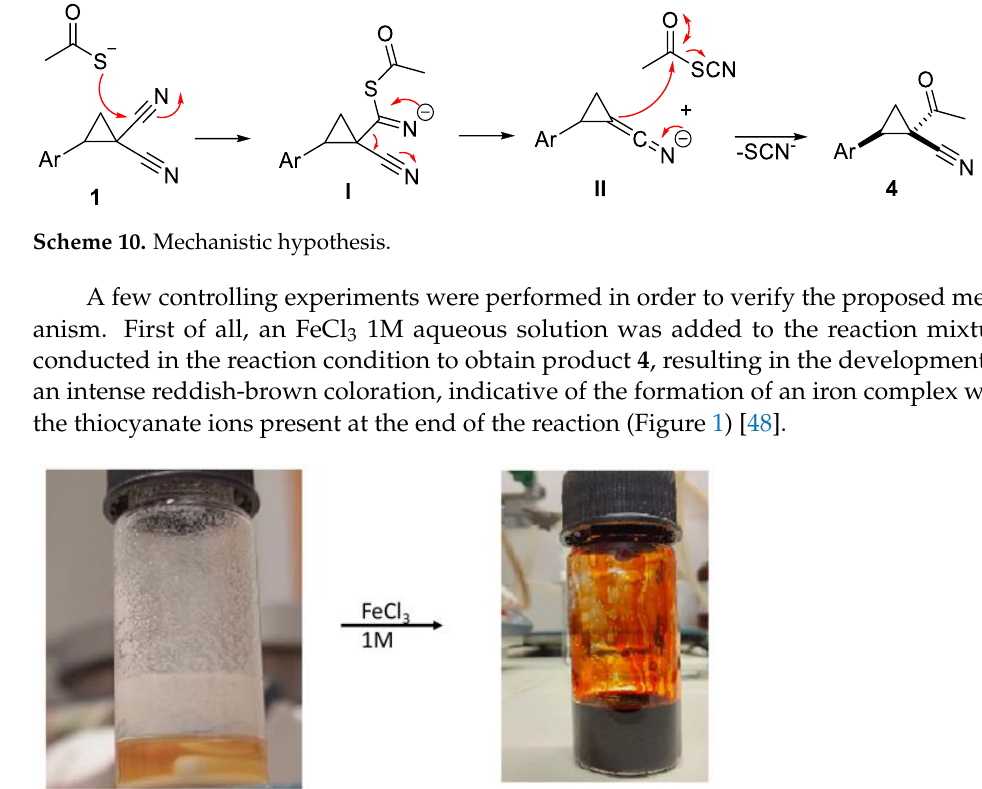
Figure 1. Visualization of thiocyanate by complexation with FeCl 3 .